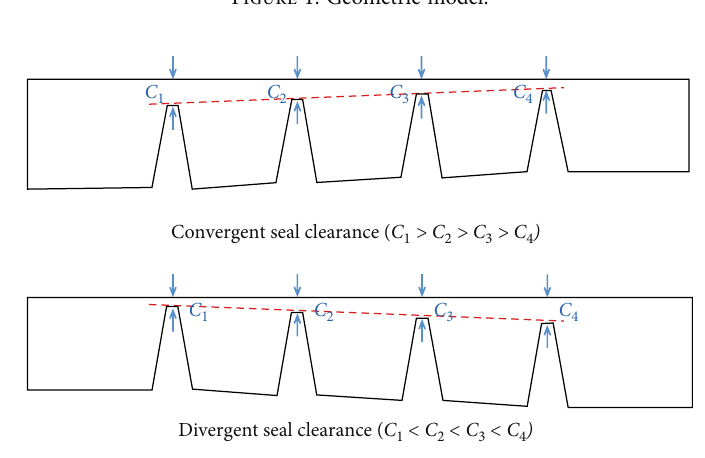
Figure 2: Nonuniform seal clearance.